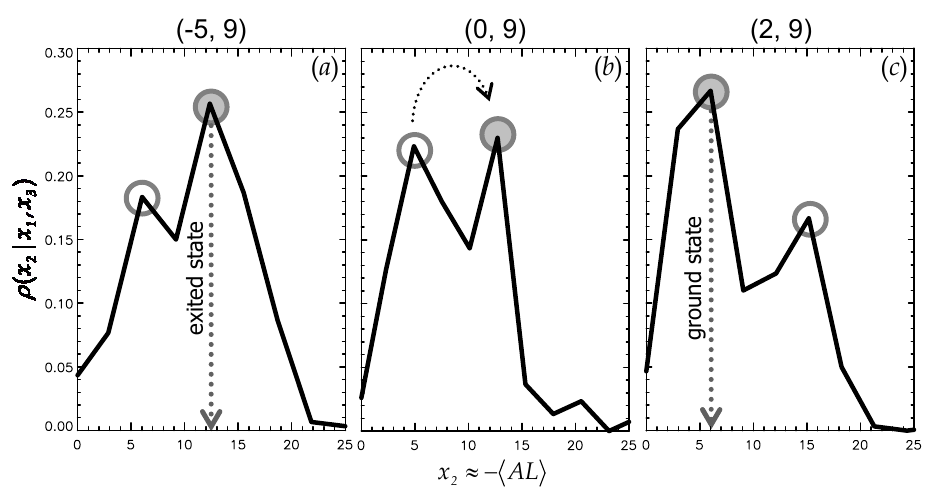
Fig. 11. Evolution of the distribution function at the different stages of substorm. Double-peak shape of the function indicate the existence of dynamical hysteresis. (c) The dominance of the left maximum indicates that the system is in the ground state (growth phase). (b) The equality of the maxima corresponds to the transition from the ground to the exited state (expansion phase). (a) Predominance of the right maximum indicates that the system is in the exited stated (late expansion or early recovery